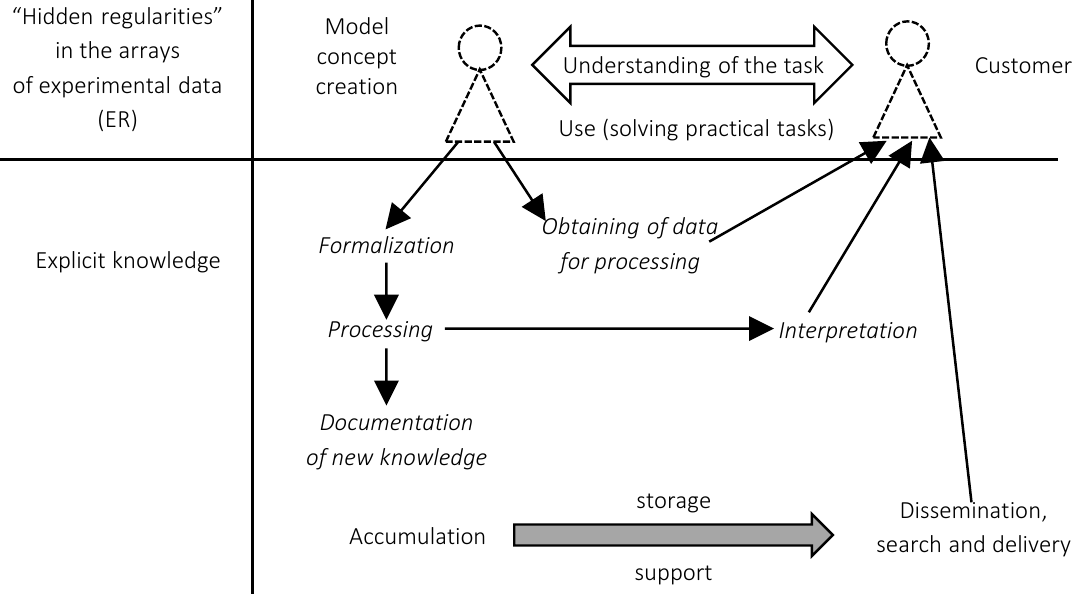
Figure 4. Search scheme for hidden empirical regularities